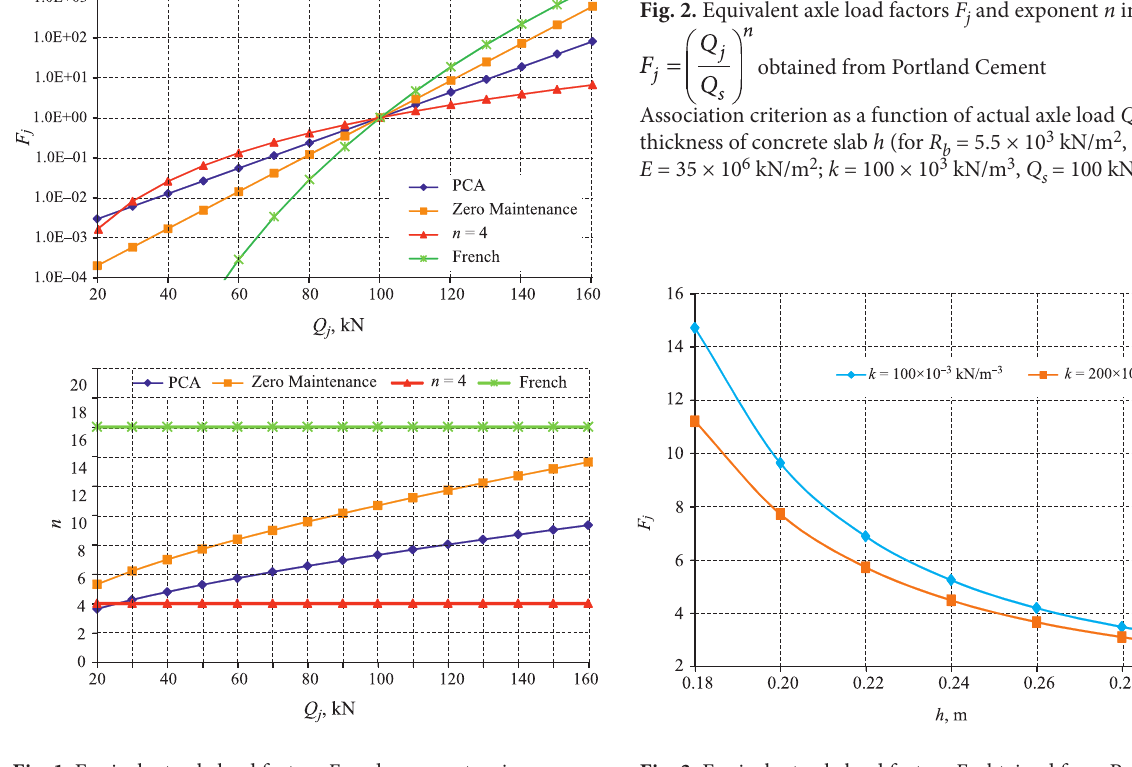
Fig. 3. Equivalent axle load factors F j obtained from Portland Cement Association criterion in relation to thickness of concrete slab h and modulus of subgrade reaction k (for standard axle load Q s = 100 kN and actual axle load Q j = 120 kN)